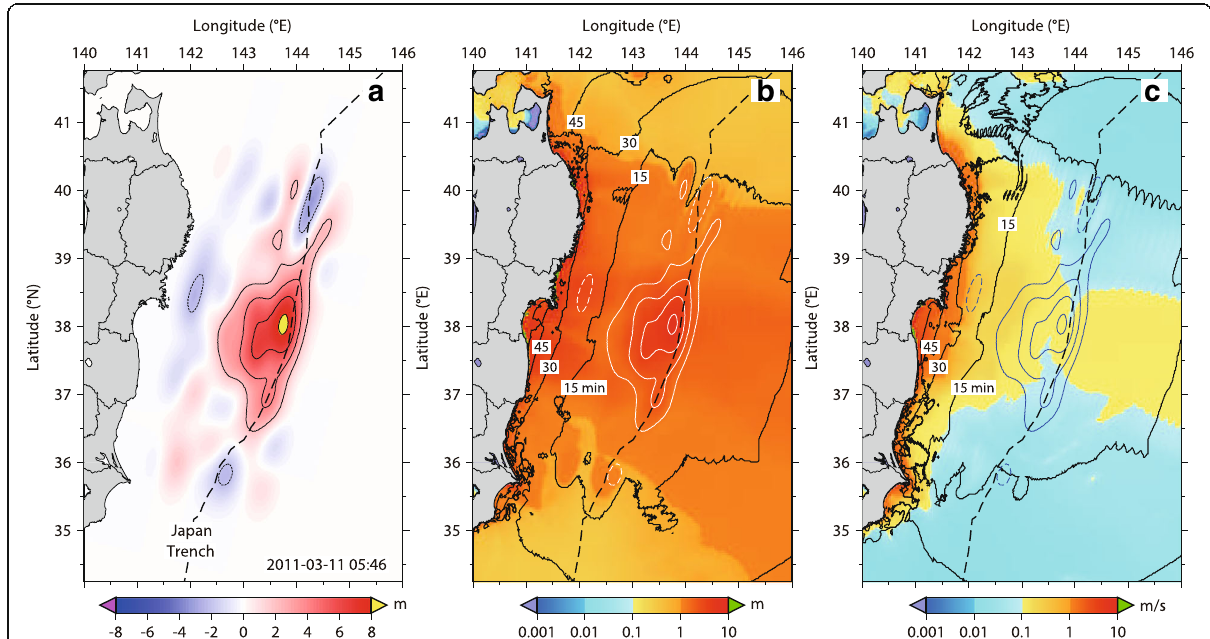
Fig. 1 a Tsunami source as sea-surface elevation due to the 2011 Tohoku tsunami (Saito et al. 2011). b Simulated maximum tsunami height with its arrival time (contours in minutes). c Simulated maximum tsunami current velocity with its arrival time (contours in minutes). The tsunami simulation is based on non-linear long-wave equations (Saito et al.